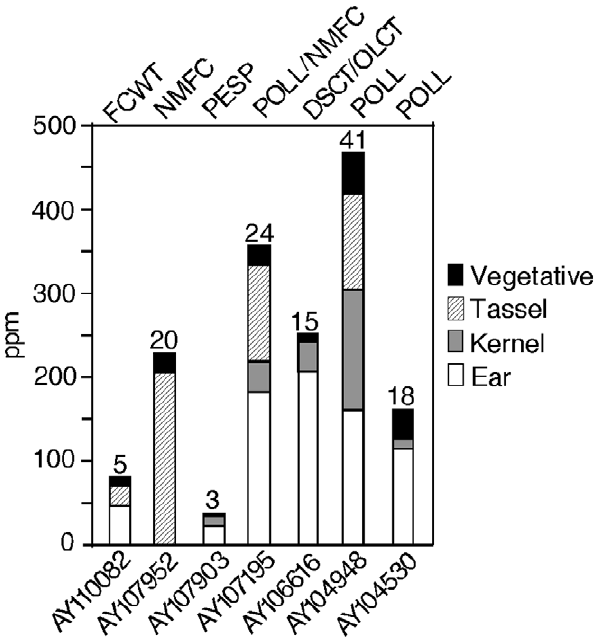
Figure 1. Expression levels of genes that associate with trait variation in teosinte in different tissue types. Expressions levels of the four tissues (ear, kernel, tassel and vegetative) were estimated using an e-northern analysis. Shading indicates tissue type. Expression level is given in parts per million. At the top of each column the number of blast hits is shown. The phenotype that each gene associated with is listed at the top of the graph. For six of the seven genes, the expression pattern was consistent with the trait(s) found to associate with that gene.